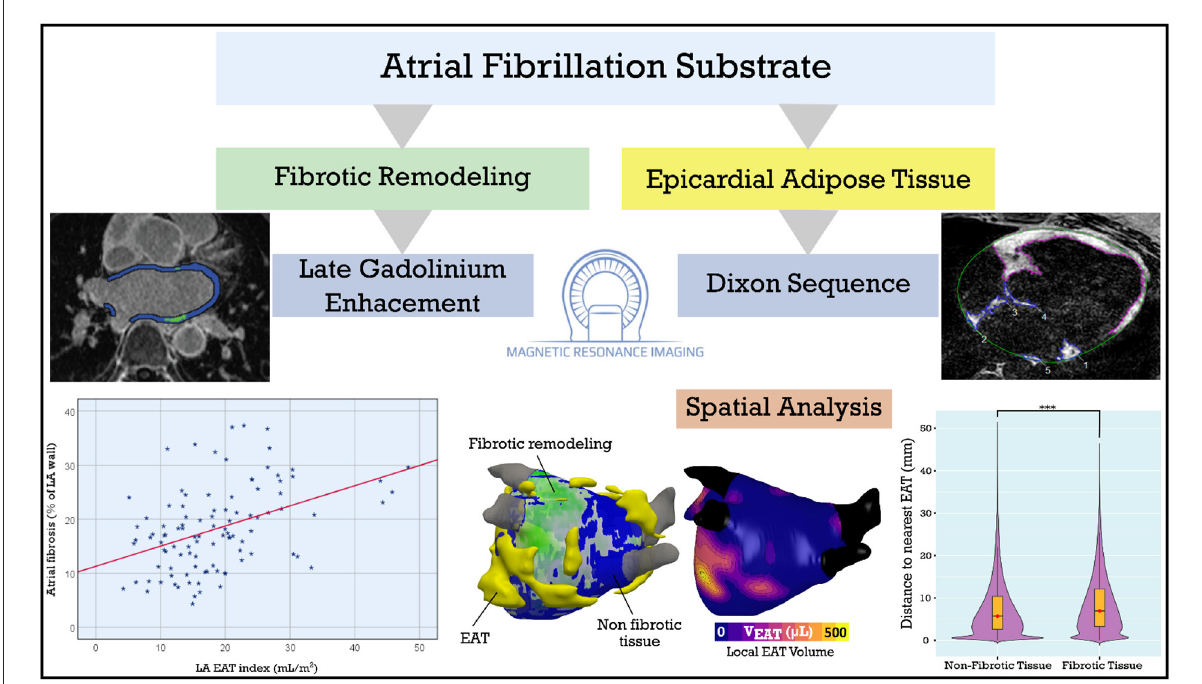
FIGURE6 Central illustration: LA EAT and fibrosis in patients with AF. LA fibrosis and EAT, assessed using late gadolinium enhancement and Dixon MRI sequences, are positively correlated. We derived 3D models incorporating LA fibrosis and EAT to assess spatial colocalization. Spatial analysis showed no predilection for overlap between EAT and fibrotic remodeling suggesting a systemic or paracrine mechanism rather than EAT infiltration of fibrotic areas. AF, atrial fibrillation; EAT, epicardial adipose tissue; LA, left atrial. *** p <